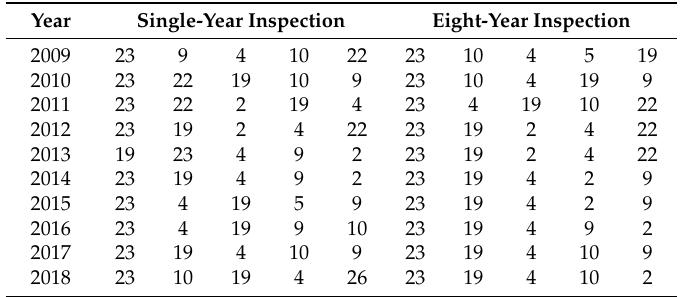
Table 2. List of explanatory variables for deck since 2009 using least absolute selection and shrinkage operator (LASSO) with and without weights.